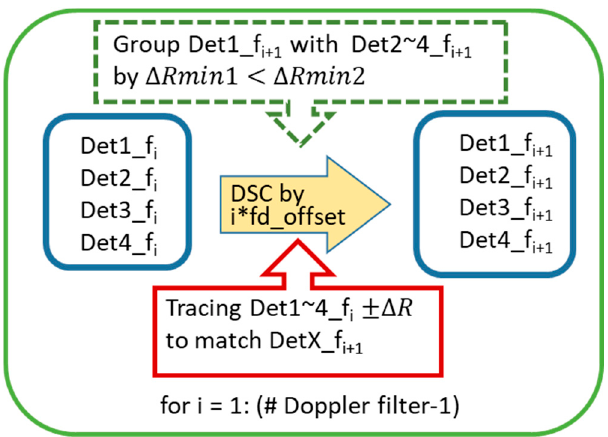
Figure 10. The processing flowchart of one Doppler filter in the multi-Doppler-shift-compensation (MDSC) scheme.